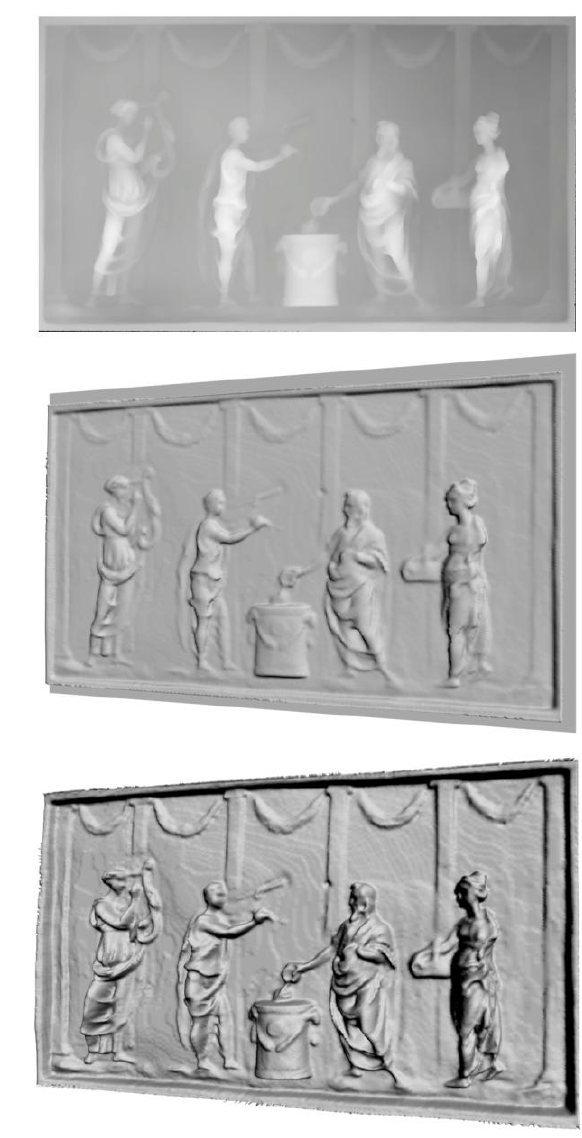
Figure 8. 3d model of a metopa in Palazzo Ducale in Mantova.